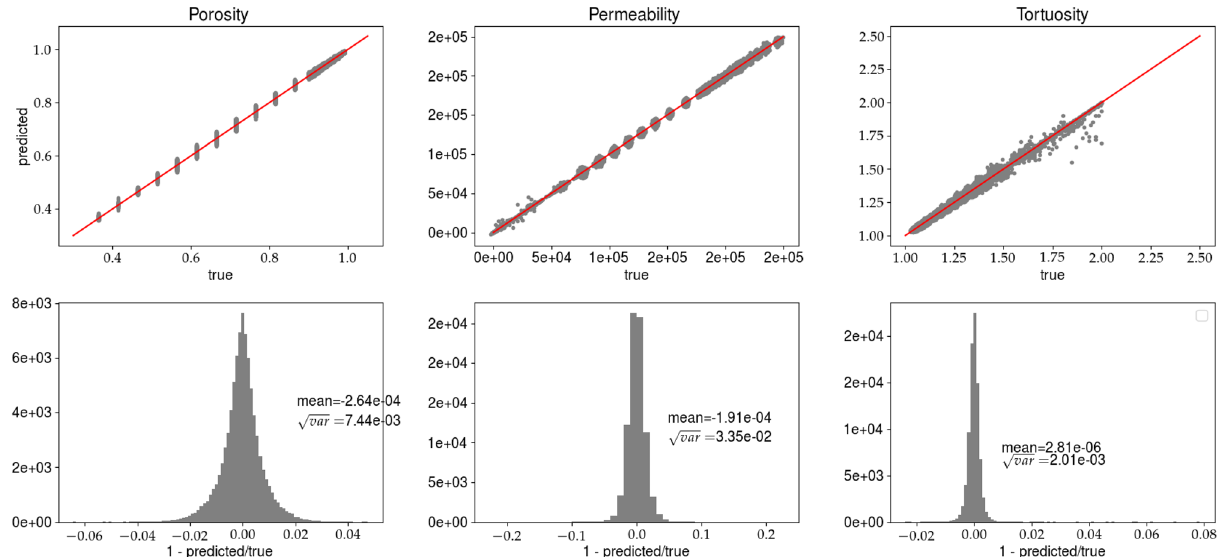
Figure 7. Predictions of porosity, permeability, and tortuosity by CNN versus ‘true‘ data (upper row). In the bottom row, the histograms of R , see Eq. (11), are plotted. The results are obtained for analysis (B) and the training data set. Solid line, in the top row, represents predicted